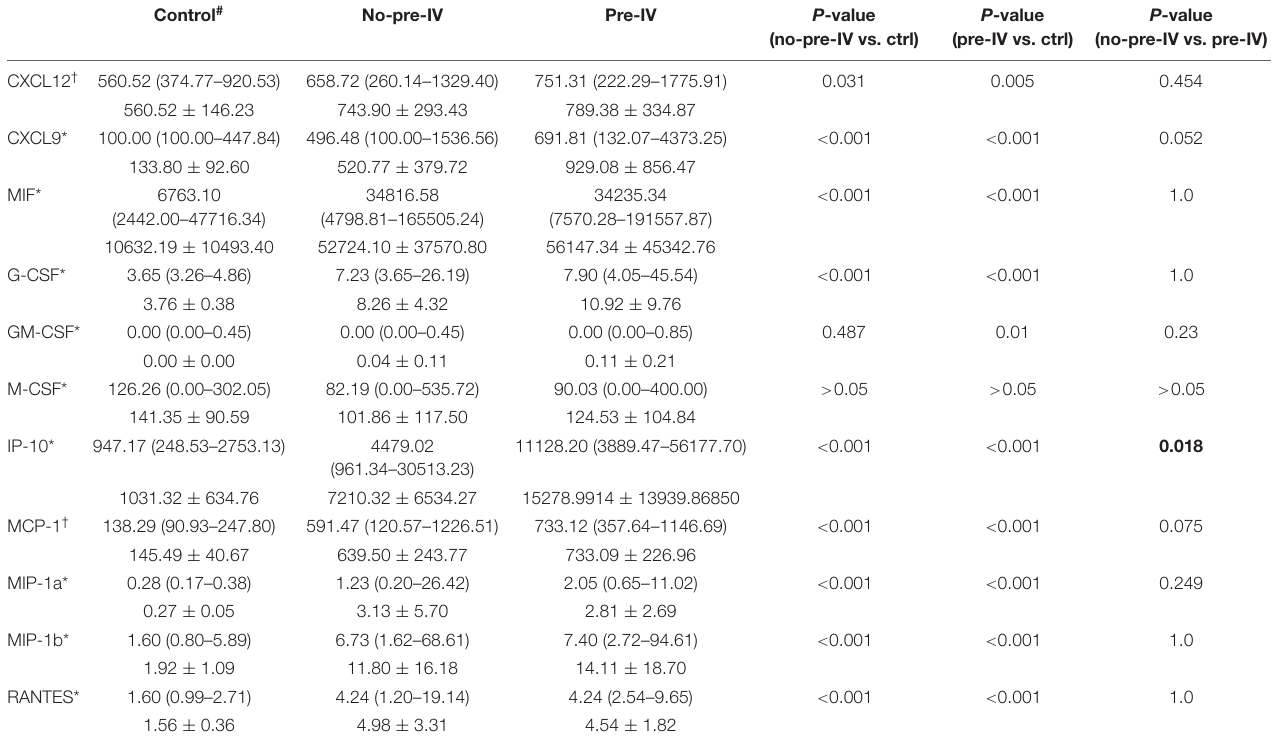
TABLE 3 | Vitreous levels of chemokines among the groups of Control, No-Pre-IV, and Pre-IV. Control # No-pre-IV